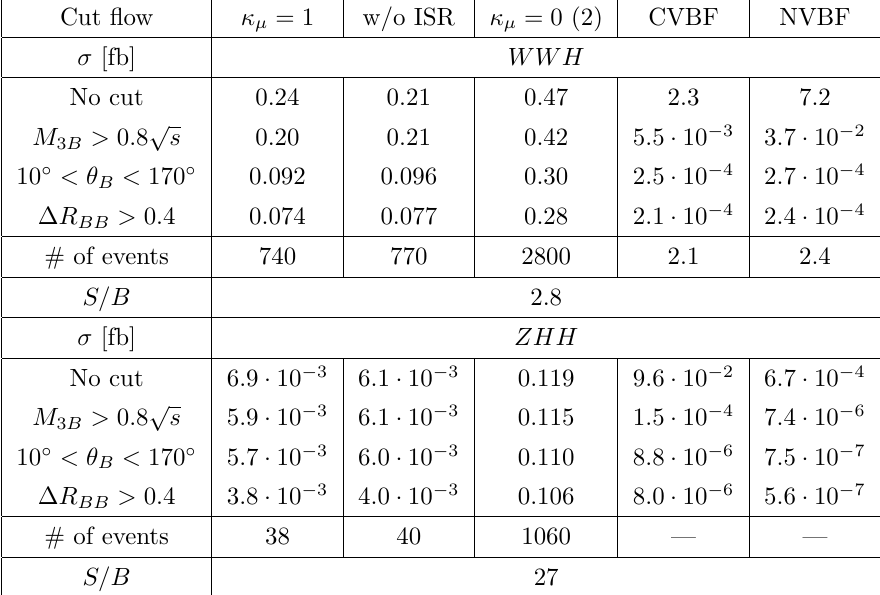
— — 27 Table 4 . The cut-flow for the cross sections of WWH and ZHH production through annihilation (SM with κ µ = 1 ) with and without ISR, and the BSM signal models for κ µ = 0 (2) (i.e., ∆ κ µ = ± 1 ). The last two columns are the SM backgrounds from charged (CVBF) and neutral vector boson fusion √ (NVBF), respectively. All cross sections are at a s = 10 TeV µ + µ − collider. The event numbers correspond to an integrated luminosity L = 10 ab − 1 . The signal and background are defined in eq.